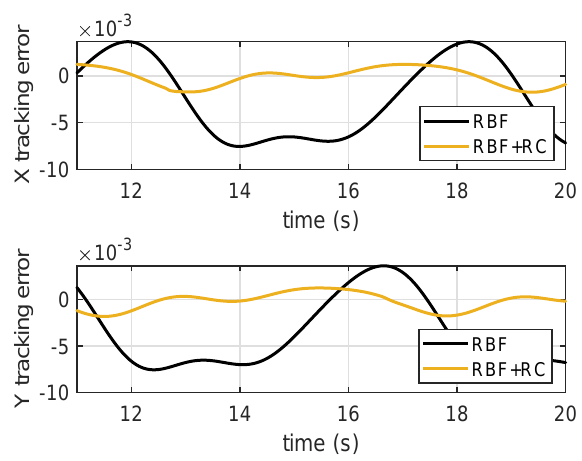
Figure 10. Axial tracking errors of integrated RC and RBF control.